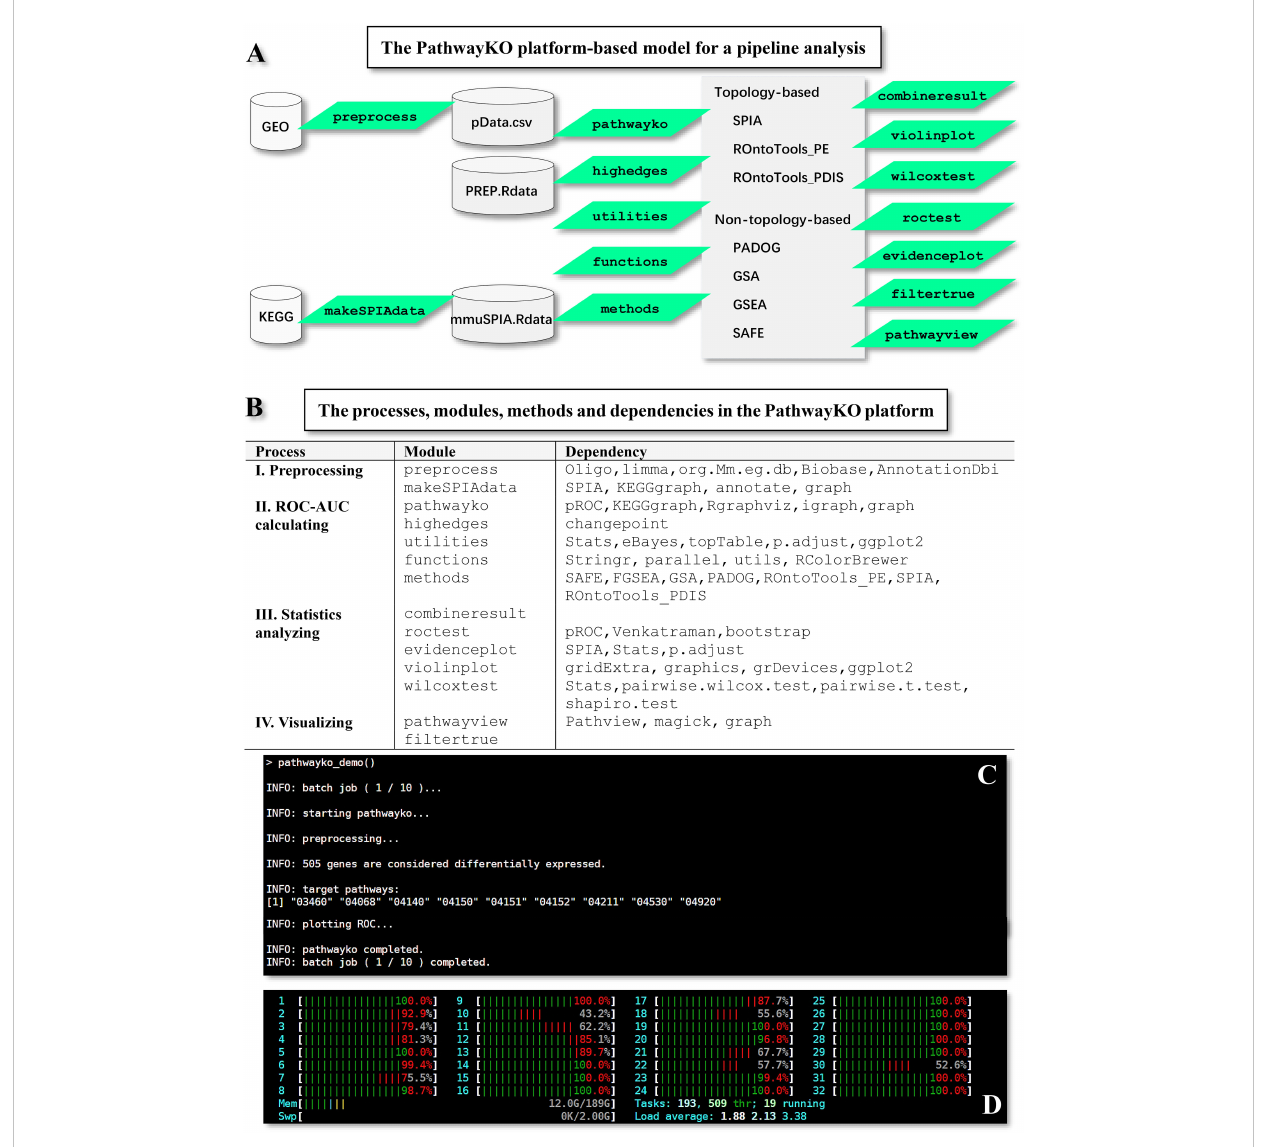
FIGURE 1 Framework overview of the PathwayKO platform. (A) Framework of the PathwayKO platform as systems software. (B) Processes, modules, methods and dependencies integrated in the PathwayKO platform. (C) Pipeline analysis with a collection of data, both across methods and across data. (D) Parallel